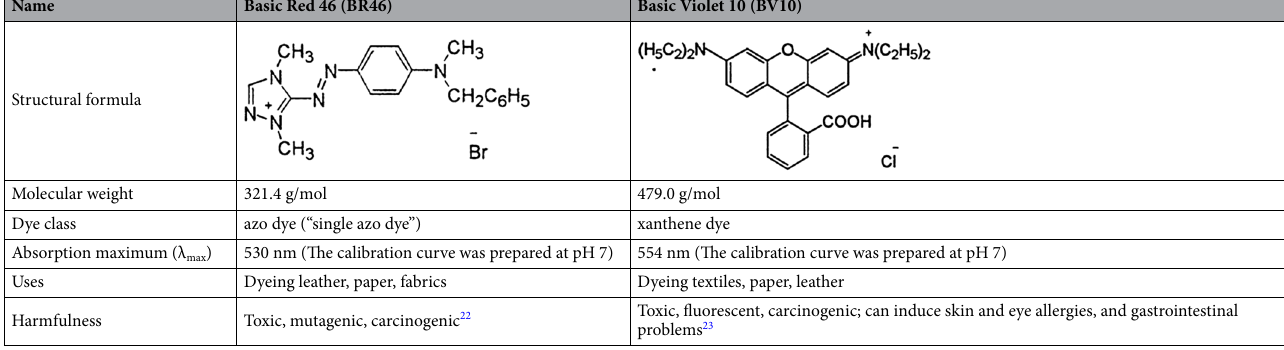
Table 1. Characteristics of Basic Red 46 and Basic Violet